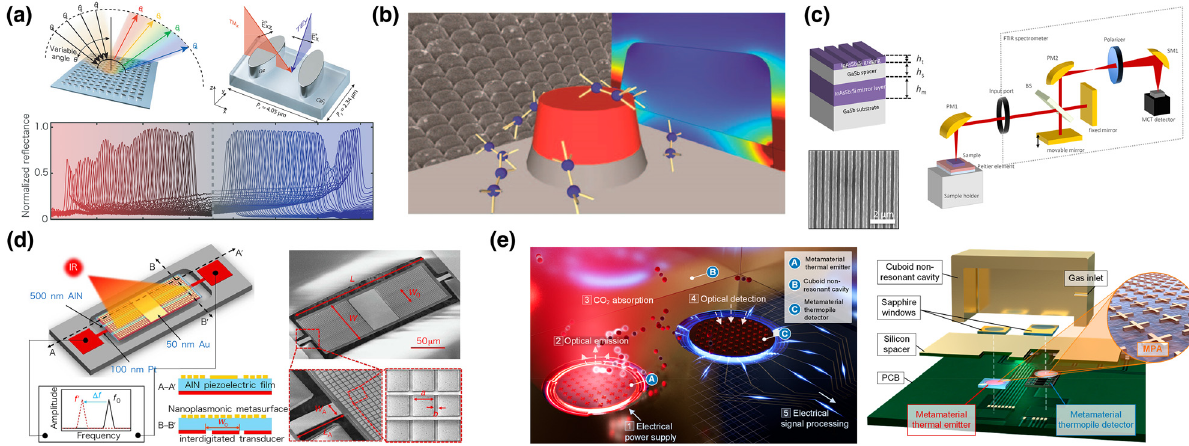
Figure 6: Metamaterial structure with new material and for new methods. (a)Theschematicsofall-dielectricmetasurfacesforangle-multiplexedbroadbandmoleculardetectionanditsexperimentalresultofreflection spectra of PMMA thin film. (b) Si-doped InAs semiconductor nanoantenna array for SEIRA. (c) The schematics of Si:InAsSb metamaterial absorber and its SEM image. The optical setup for surface-enhanced thermal emission spectroscopy was also shown. (d) The schematic